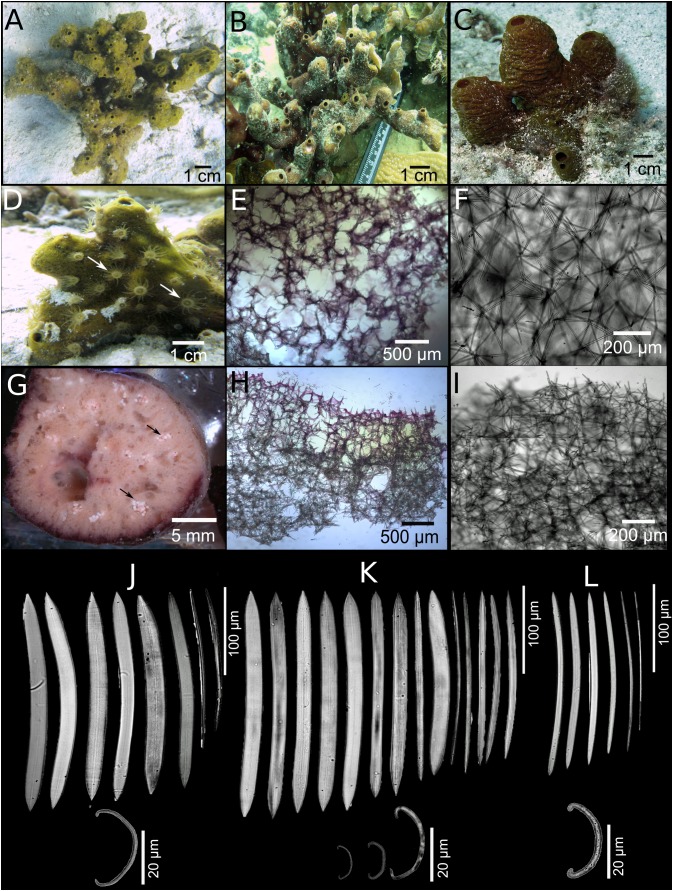
Neopetrosia sigmafera sp. nov.In situ images of the holotype UF 3857 (A) and individuals PPA 38 (B), both from Panama, and SZ-21 from Martinique (C), with corresponding images (D) of zoanthids; (E and F) tangential sections of the ectosome (LM); (G) brooding larvae (arrows) (H and I) perpendicular sections through the ectosome and choanosome (LM); Size and morphological variations of oxeas and sigmas from (J) Panama, (K) Cartagena, (L) Martinique (LM).